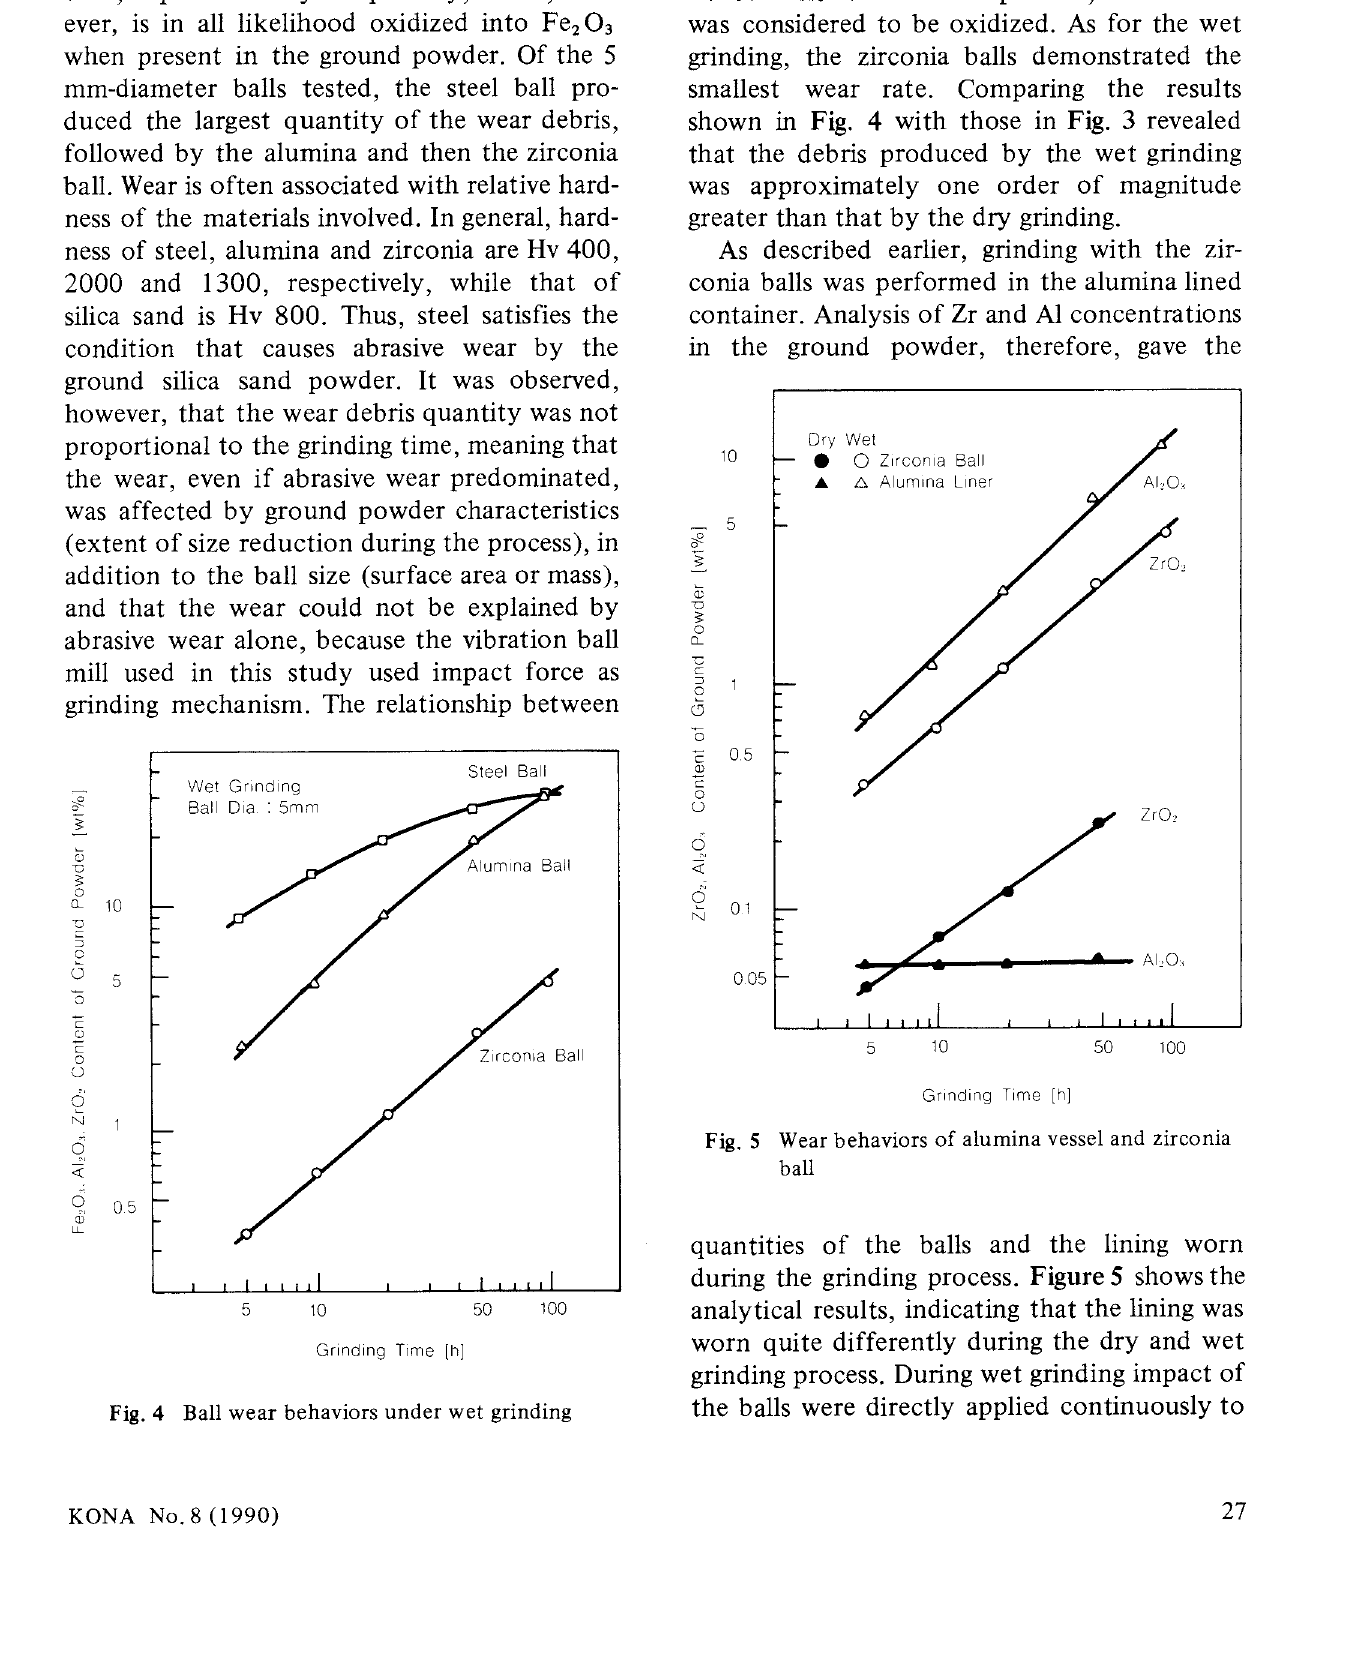
Fig. 5 Wear behaviors of alumina vessel and zirconia